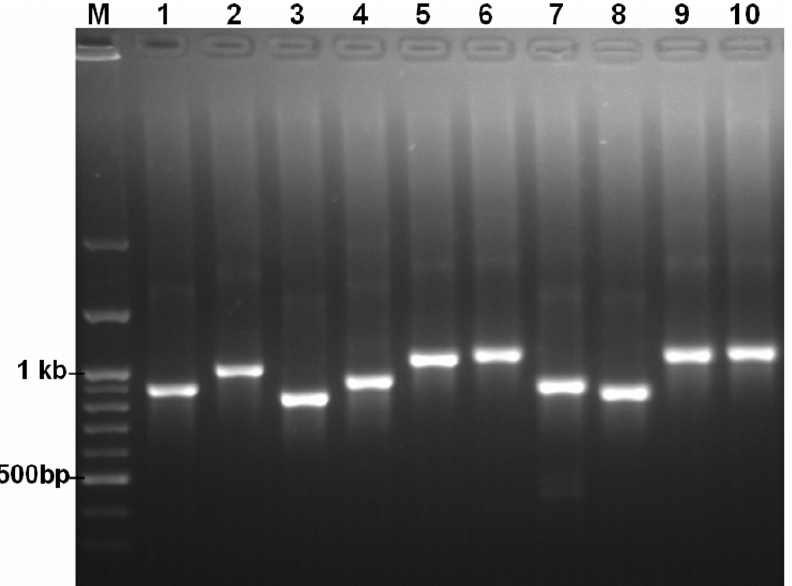
Figure 7. Demonstration of the PCR performance for ten sets of designed conserved primers. Lanes 1 to 10 are the PCR amplification using primer sets 1 to 10 listed in the Table 1.